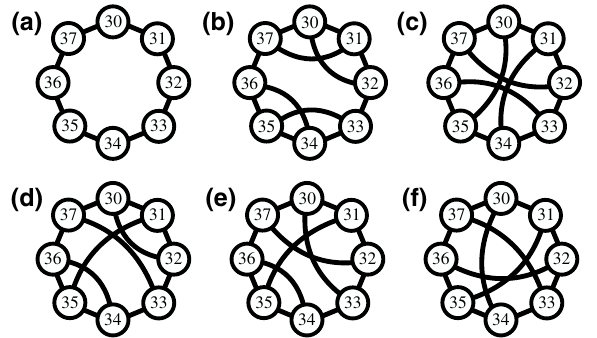
FIG. 5. (a) The native topology on the Rigetti Aspen-M-1 for the eight qubits labeled 30, 31, 32, 33, 34, 35, 36, and 37 that we use for the experiment. (b)–(f) There exist five different unit- weight 3-regular graphs with N = 8 vertices: (b) is considered in Fig. 4 of the main text, while (c)–(f) are considered in Fig.